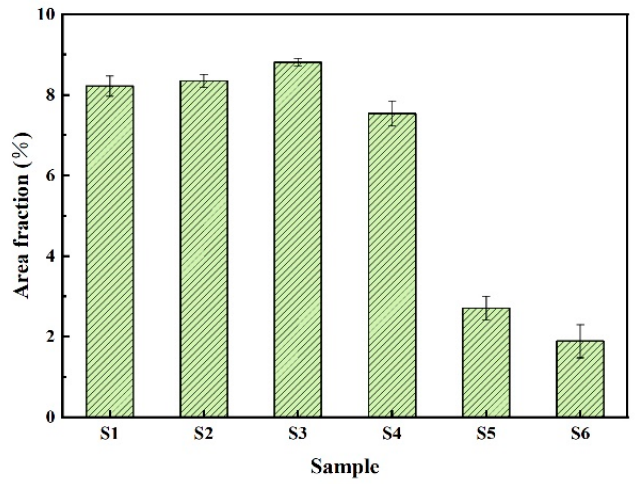
Figure 9. The area fraction of Cr 23 C 6 phase.